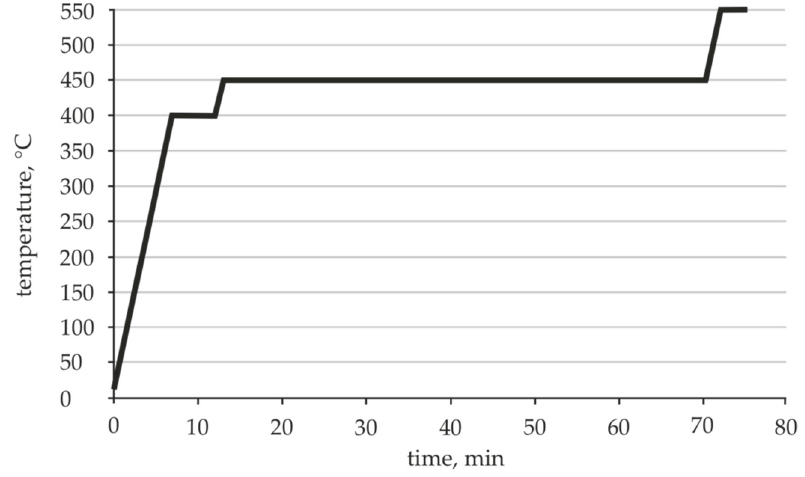
Figure 6. Graphical representation of the temperature-time curve for an exemplary heat treatment of a foamable sample at 550 °C for 3 min.